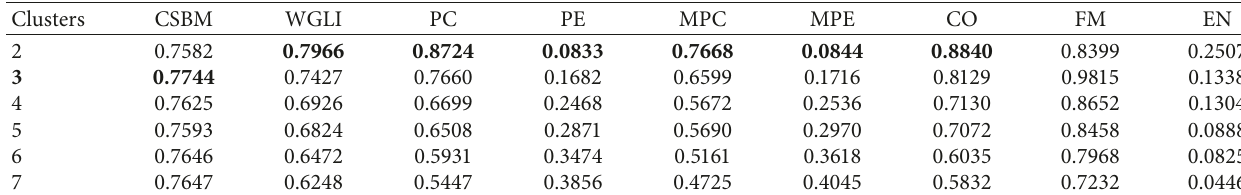
Table 3: Values of each index on the iris dataset.